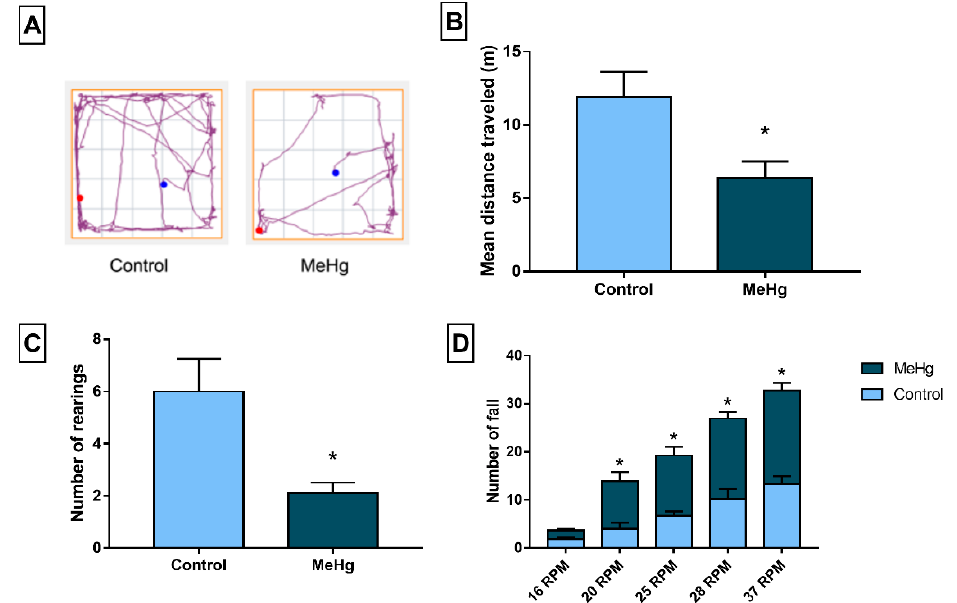
Figure 6. Effects of long-term exposure to MeHg (40 µg/kg/day) for 60 days on spontaneous and forced motor locomotion in Wistar rats. ( A ) Tracking plot of horizontal locomotor activity, where blue dots are for the initial position and red dots, final position ( B ) mean total distance traveled, and ( C ) number of rearings in the open field test. ( D ) Number of falls in the rotarod test. Results are expressed as means ± standard errors of the means (SEMs). n = 10 per group. The open-field parameters were analyzed using the Student’s t -test and the number of falls in the rotarod test by two-way ANOVA and Sidak’s post hoc test. * p < 0.05.